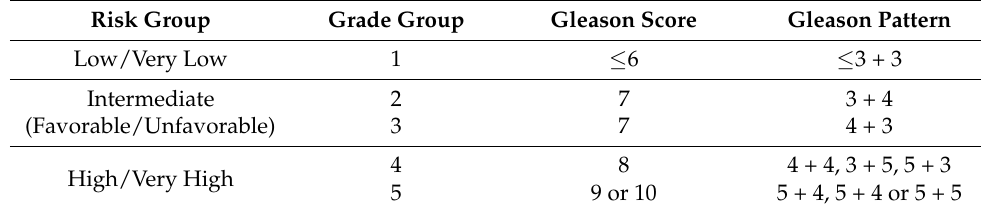
Table 2. ISUP PCa grading system.